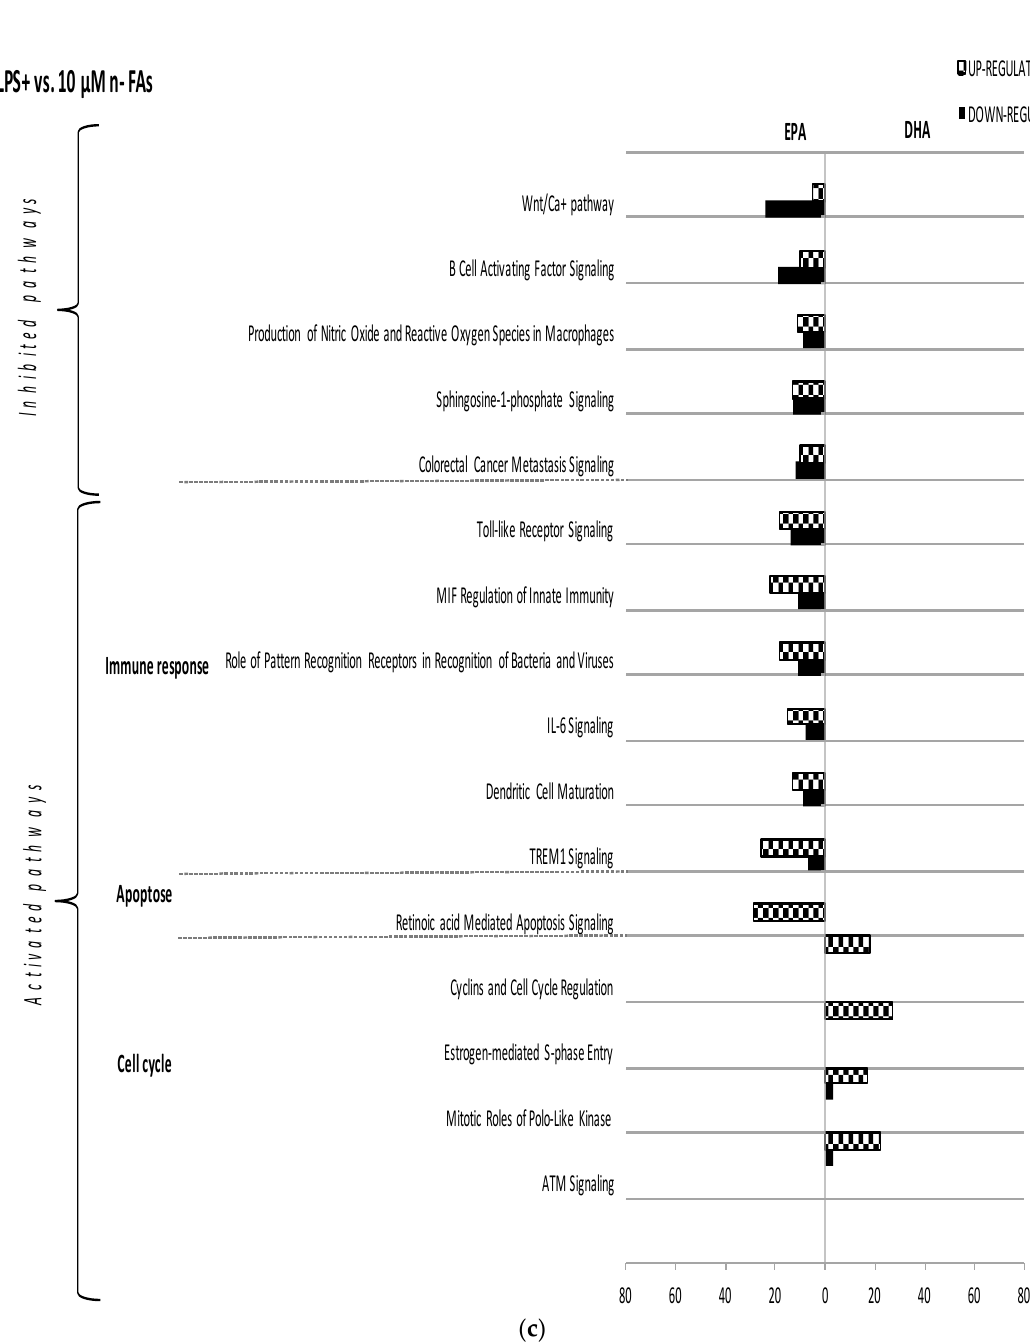
Figure 3 . Impact of EPA and DHA on canonical pathways in LPS-stimulated macrophages. The effect of 75, 50 and 10 µ of EPA or DHA on gene regulation in LPS-stimulated macrophages is shown (( A – C ), respectively). Differentially expressed genes are organized in canonical pathways regrouped into different families ( immune response , apoptosis , cellular cycle , and other pathways ). The amount of up- and down-regulated genes within each pathway is also shown (horizontal grey and black bars, respectively). MIF: macrophage migration inhibitory factor, IL: interleukin, TREM: Triggering receptor expressed on myeloid cells 1, ATM: Ataxia telangiectasia Mutated, NFKB: nuclear factor-kappa B, NRF2: Nuclear factor 2, ERK5: Extracellular-signal-regulated kinase 5, RXR: Retinoid X receptor, LXR: Liver X receptor.